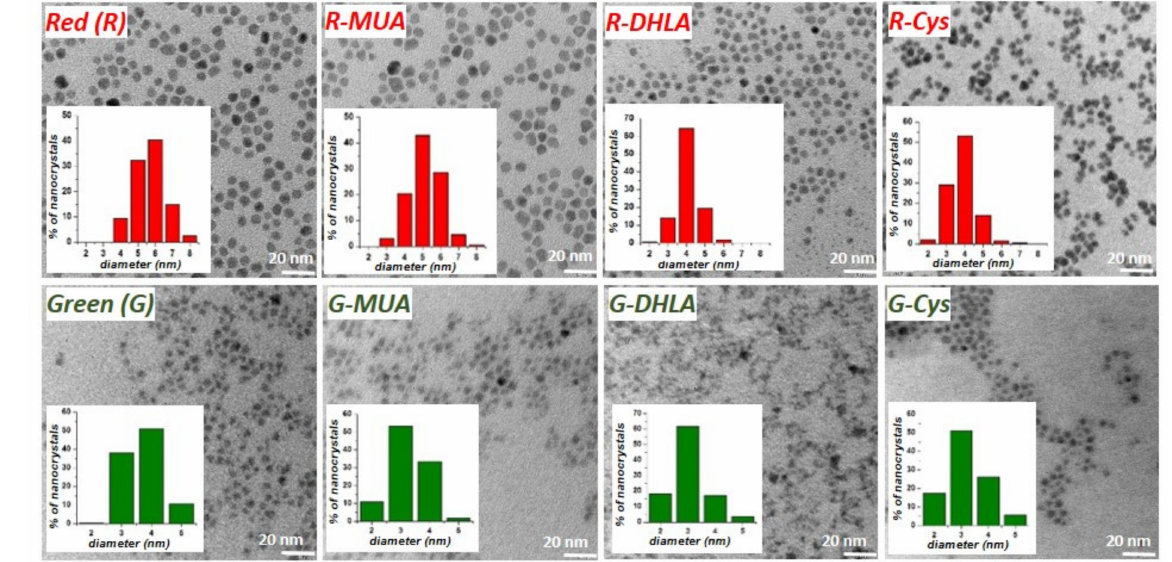
Figure 1. TEM images of alloyed AgInS 2 -ZnS nanocrystals ( R-“Red” and G-“Green” ) before and after the exchange of initial capping ligands for 11-mercaptoundecanoic acid ( MUA ), dihydrolipoic acid ( DHLA ), L-cysteine ( Cys ), and their histograms.